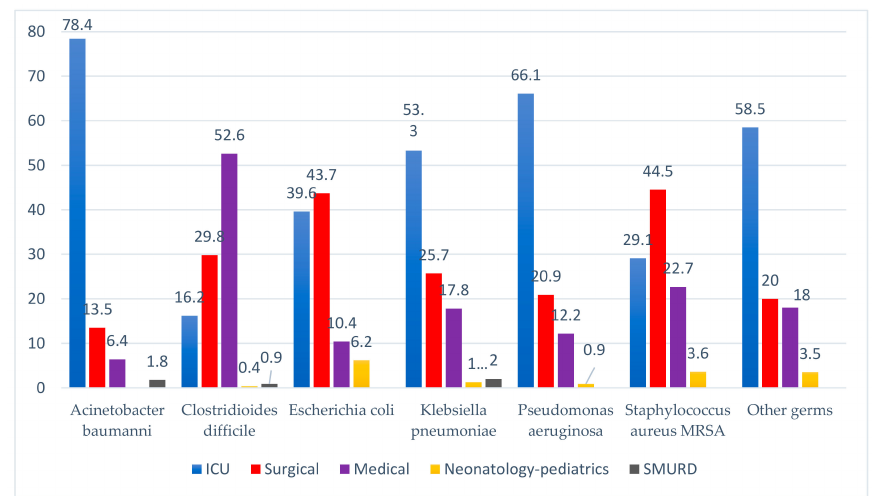
Figure 1. The evidence of the pathogen according to the type of section